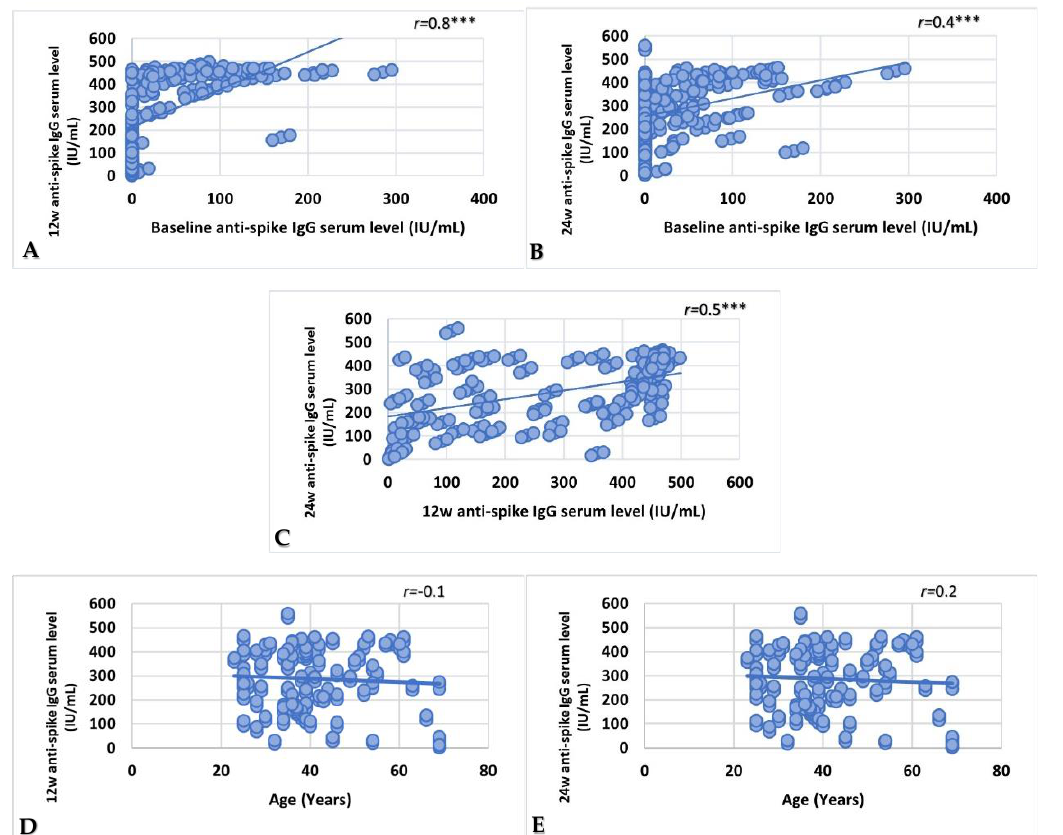
Figure 5. Correlations between ( A ) baseline and 12 w, ( B ) baseline and 24 w, ( C ) 12 w and 24 w anti-spike IgG serum levels. Correlations between age and ( D ) 12 w and ( E ) 24 w anti-spike IgG serum levels. Correlations were measured by Spearman’s rank correlation coefficient (r) and significant difference was defined as *** p < 0.001. w, week.